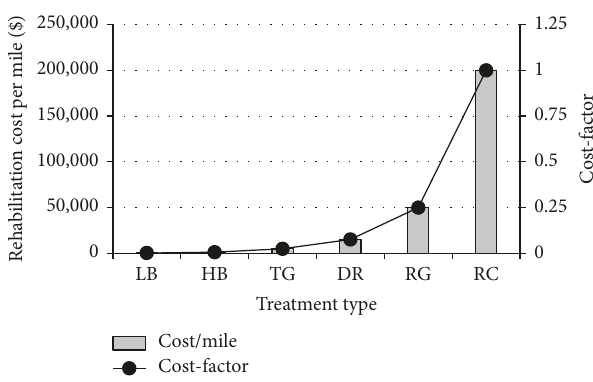
Figure 3: Variation of cost-factor associated with treatment